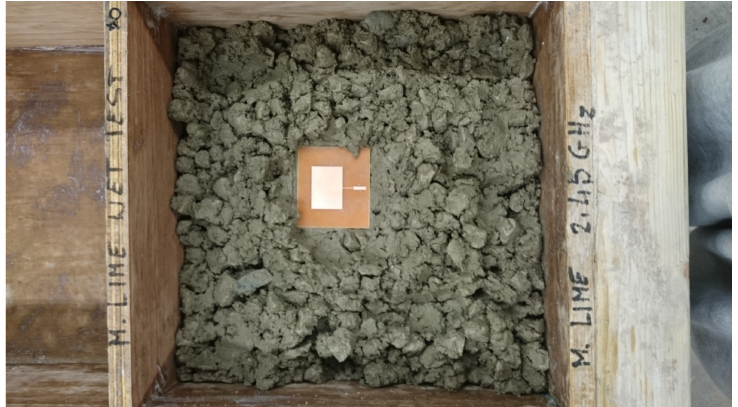
Figure 4. Smart sensor is embedded in the concrete block for moisture detection.